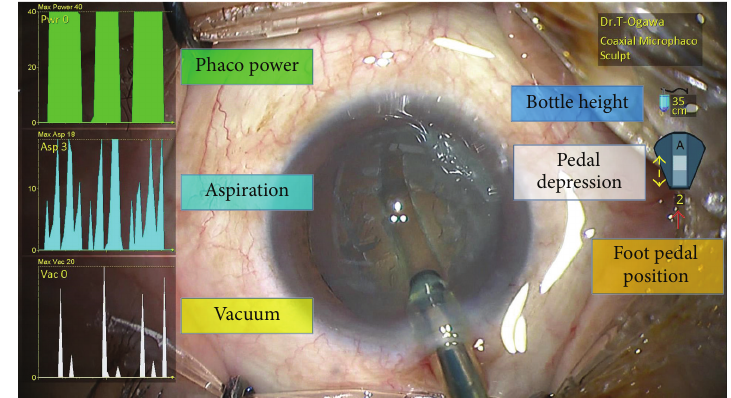
Figure 2: An example of display by the High-Definition Surgical Media Center